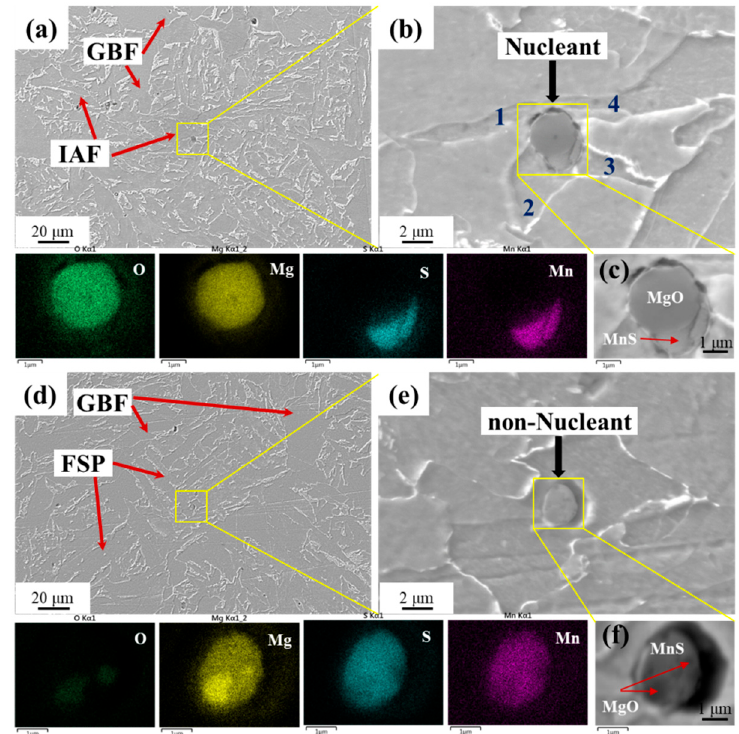
Figure 9. Morphologies and SEM mapping images of inclusions in HAZ microstructures for experimental steels. ( a – c ) 3Mg1Al; ( d – f ) 3Mg20Al.